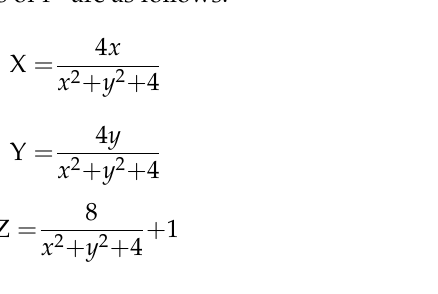
Figure 5. Cross-section of the UV plane and sphere when the stereographic projection is used.